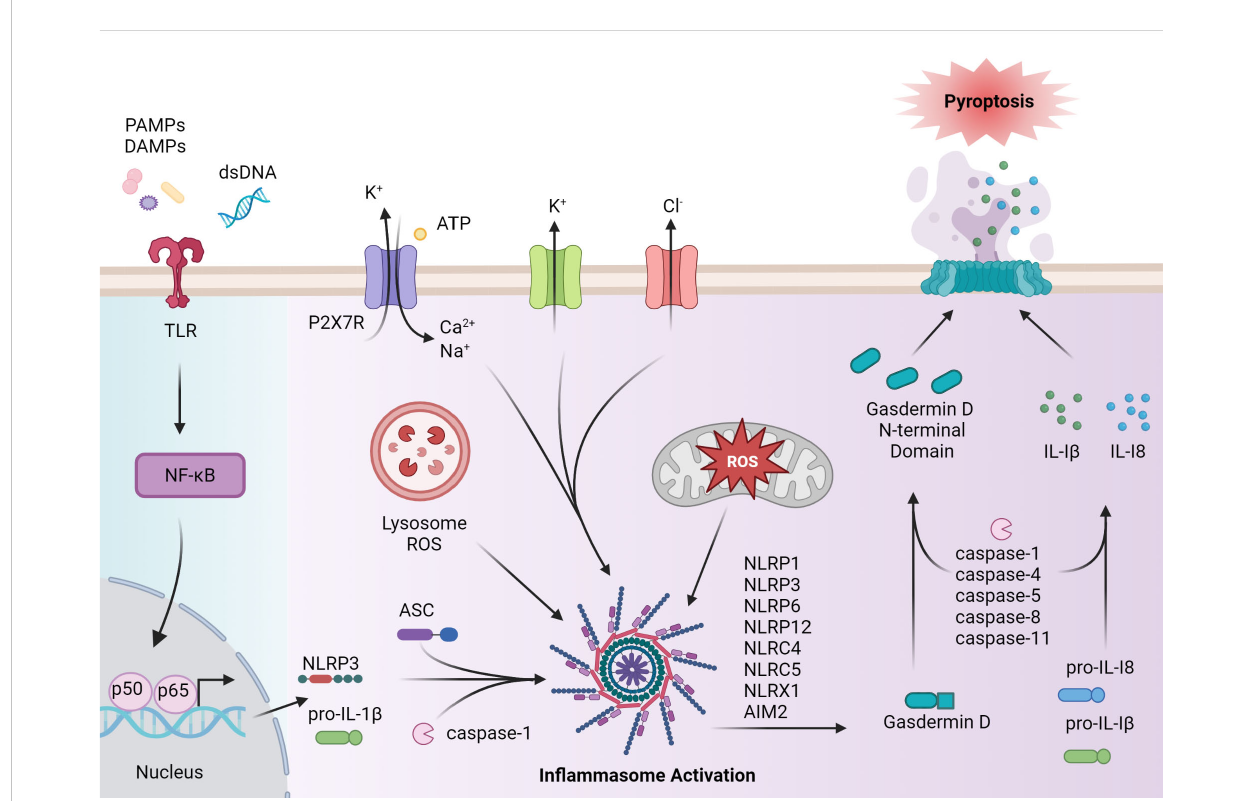
FIGURE 1 In fl ammasome assembly and activation. Canonical activation of the in fl ammasome pathway begins with a primary signal, such as PAMPs, endogenous-derived DAMPs, or dsDNA, that are recognized by pattern recognition receptors (PRRs), such as toll-like receptors (TLRs). PRR activation induces NF- k B and subsequent expression of NLRP, pro-IL-1 b and pro-IL-18, and post-translational events. Formation of the in fl ammasome complex occurs when the sensor protein, such as NLRP3, binds to ASC, driving caspase activation and in fl ammasome assembly. Caspase enzymes cleave pro- IL-1 b and pro-IL-18 as well as the C terminus from gasdermin D, allowing the gasdermin D N-terminal domain to form pores necessary for pyroptosis. IL-1 b and IL-18, as well as cellular contents are released to establish a proin fl ammatory response. In autoimmune disease, in fl ammasome activation can occur via activation in a noncanonical matter including agonist-induced ion fl ux and lysosomal and mitochondrial reactive oxygen species (ROS). The fi gure was prepared using Biorender software licensed to the UNC Lineberger Comprehensive Cancer